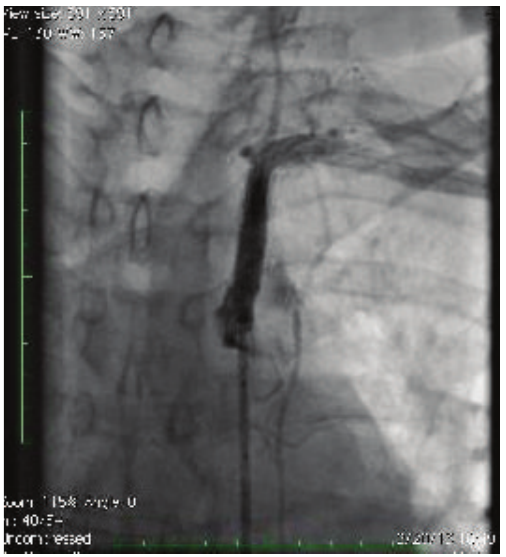
Figure 7: Angiogram after stent placement showing trapped in- stent